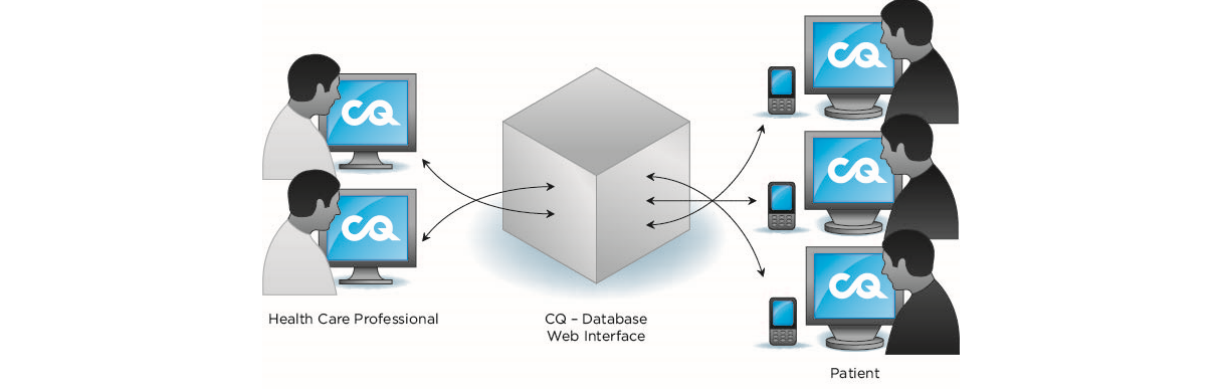
Figure 1. The collected and identified data are transferred safely to a secure database via the Internet as data traffic (reproduced with permission from 21st Century Mobile